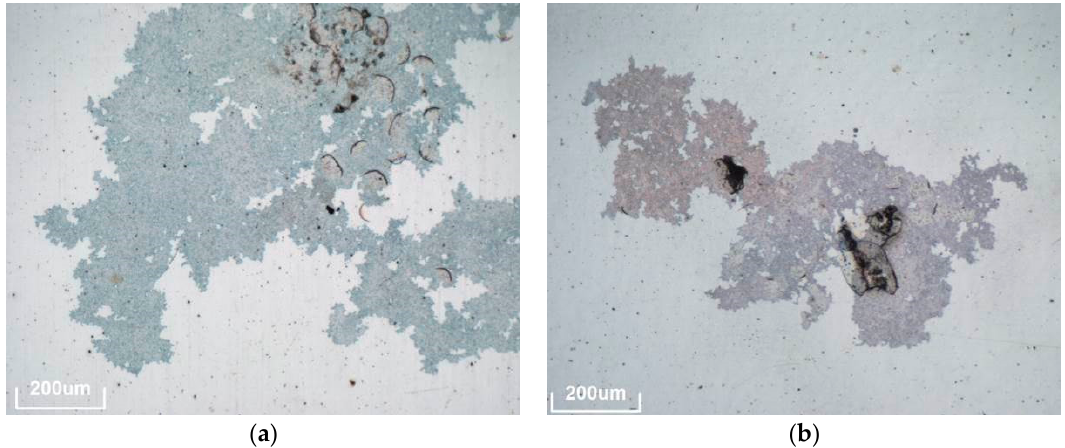
Figure 3. Microscopic views of degradation due to corrosion of the aluminum PVD layer. ( a ) material D after 6 months outdoor; ( b ) material B after 12 months.